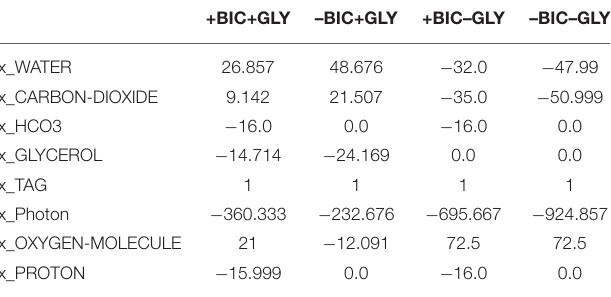
TABLE 2 | Net production and consumption of substrates (net stoichiometry of linear programming solution) for each